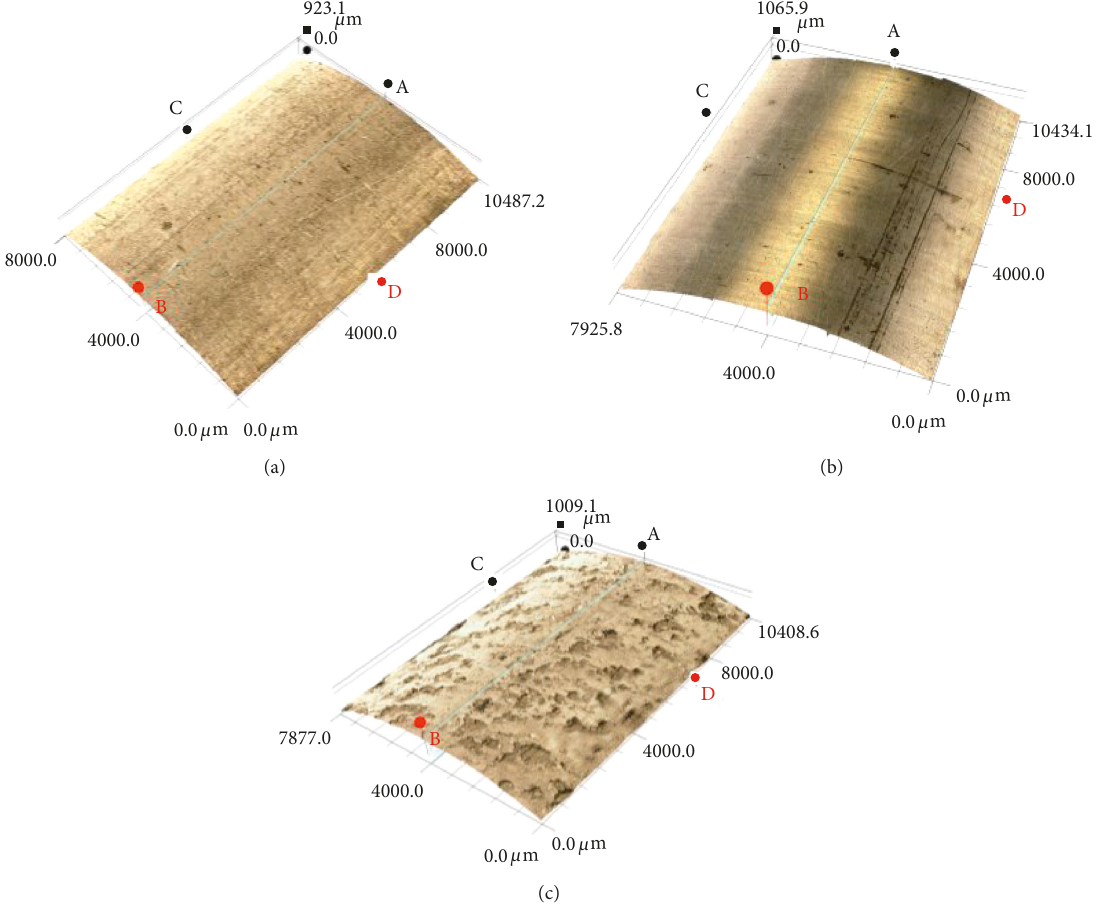
Figure 14: Tube after spinning at different thickness reductions. (a) R and t 0.2mm. (c) R (cid:31) Δ